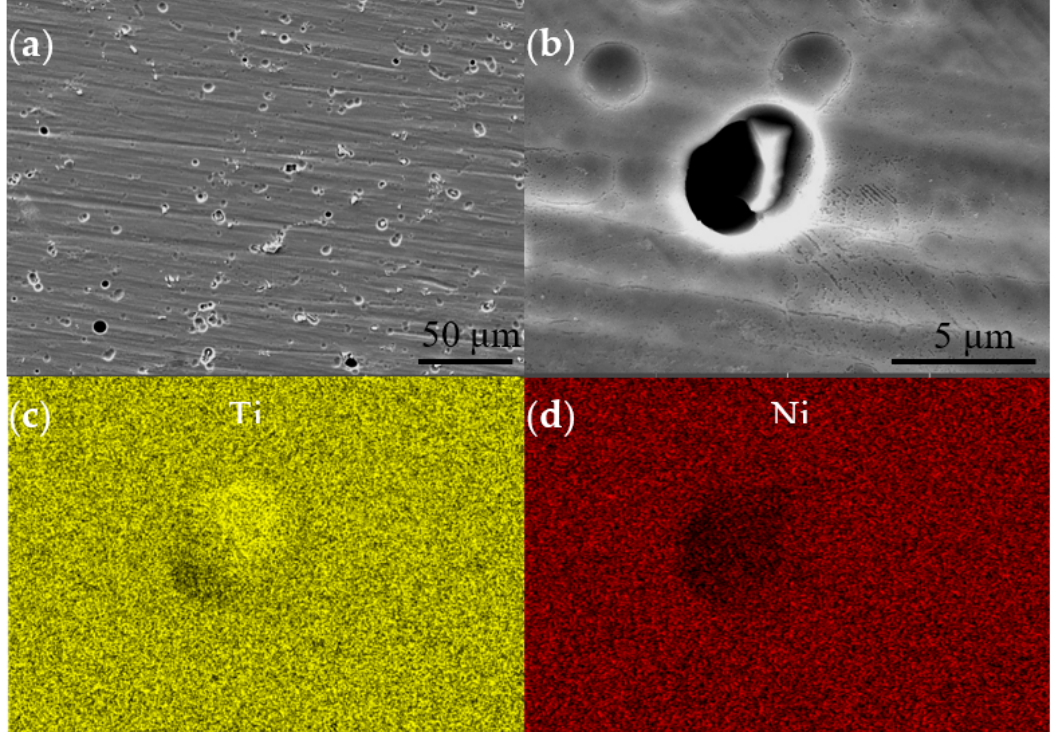
Figure 10. SEM and EDS images of SLM sample after corrosion in ASS in 0.5% F − ASS at pH 4. ( a ) is SEM image of corrosion pits; ( b ) is enlarged SEM image of a corrosion pit shown in ( a ); ( c ) is EDS image of Ti for the whole area shown in ( b ); ( d ) is EDS image of Ni for the whole area shown in ( b ).